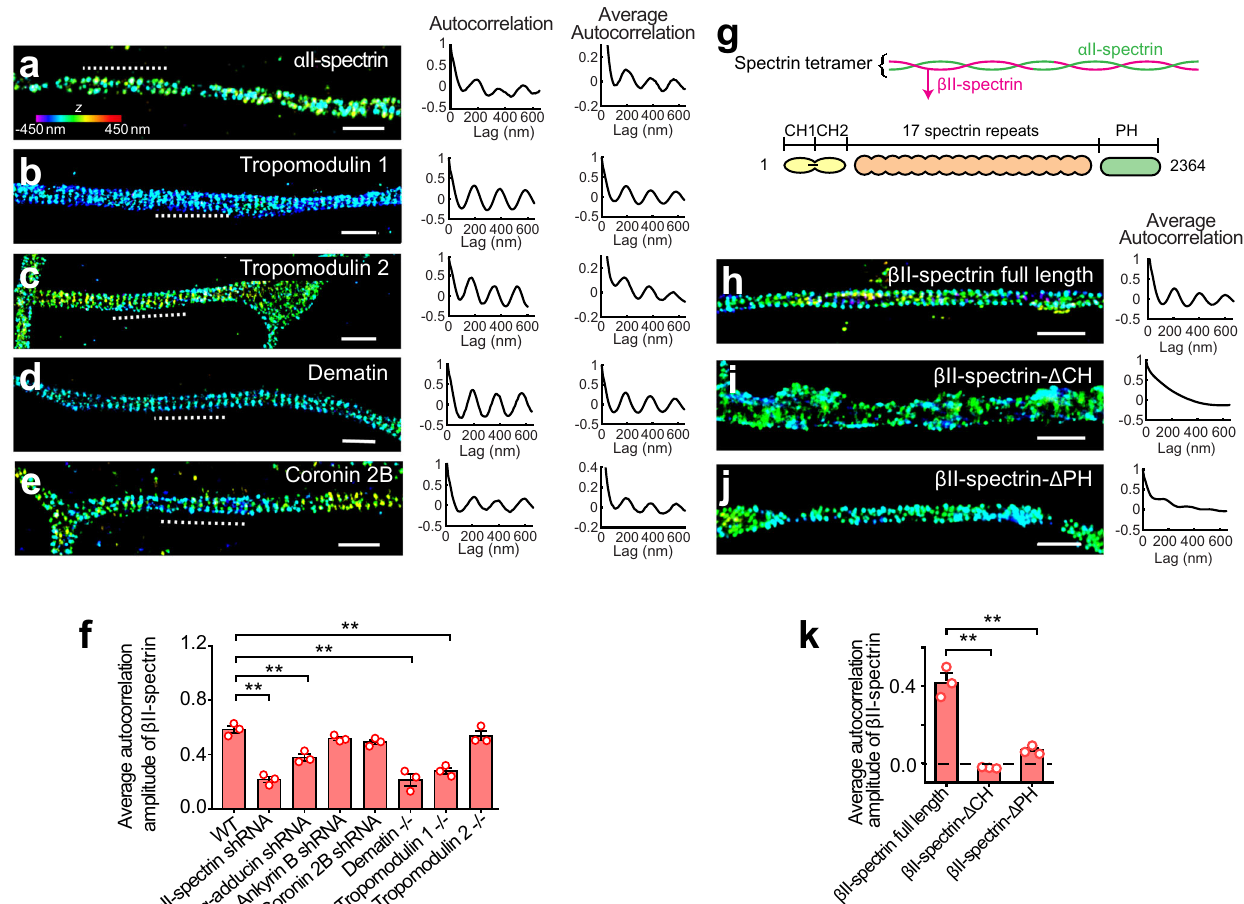
Fig. 2 Super-resolution imaging of actin-binding MPS components. a – e Left: 3D STORM images of α II-spectrin ( a ), tropomodulin 1 ( b ), tropomodulin 2 ( c ), dematin ( d ), and coronin 2B ( e ) in axonal regions of cultured hippocampal neurons. Middle: One-dimensional (1D) autocorrelation of the imaged molecules for the axon region indicated by the dashed line in the left panels. Signals were projected to the longitudinal axis of the axon segment, and 1D autocorrelation was calculated using the projected signals. Right: Average 1D autocorrelation of the imaged molecules over 20 – 80 randomly selected axon regions. Scale bars: 1 μ m. Colored scale bar indicates the z-coordinates. f Average 1D autocorrelation amplitudes of the β II-spectrin distribution, indicating the degree of periodicity of the MPS, of untreated neurons, neurons transfected with adenoviruses expressing α II-spectrin shRNA, α -adducin shRNA, ankyrin B shRNA, or coronin 2B shRNA, and neurons cultured from tropomodulin 1, tropomodulin 2 or dematin knockout mice. Data are mean ± s.e.m. ( n = 3 biological replicates for each condition; 40 – 80 axonal regions were examined for each condition). ** p < 0.005 (two-sided unpaired Student ’ s t-test); p-value s (from left to right): 6.0 × 10 − 4 , 4.9 × 10 − 3 , 4.0 × 10 − 3 and 1.1 × 10 − 3 . g Domain organization of β II-spectrin. h – j Left: 3D STORM image of axon regions of β II-spectrin knockout neurons transfected with plasmid expressing GFP-tagged full length β II-spectrin ( h ), β II-spectrin- Δ CH mutant ( i ) or β II- spectrin- Δ PH mutant ( j ). The proteins were visualized by immunostaining with anti-GFP antibody. Scale bars: 1 µ m. Right: average 1D autocorrelation of the imaged proteins. k Average 1D auto-correlation amplitudes for the distributions of GFP-tagged full length β II-spectrin and two GFP-tagged β II-spectrin truncation mutants, as described in ( h – j ), calculated from GFP-positive axon segments. Data are mean ± s.e.m. ( n = 3 biological replicates for each condition; 30 – 70 axonal regions were examined for each condition). ** p < 0.005 (two-sided unpaired Student ’ s t-test); p -values (from left to right): 1.3 × 10 − 3 and 1.4 × 10 − 4 . STORM images in a – e and h – j are representative examples from three independent experiments with similar results. Source data are provided in the Source Data fi